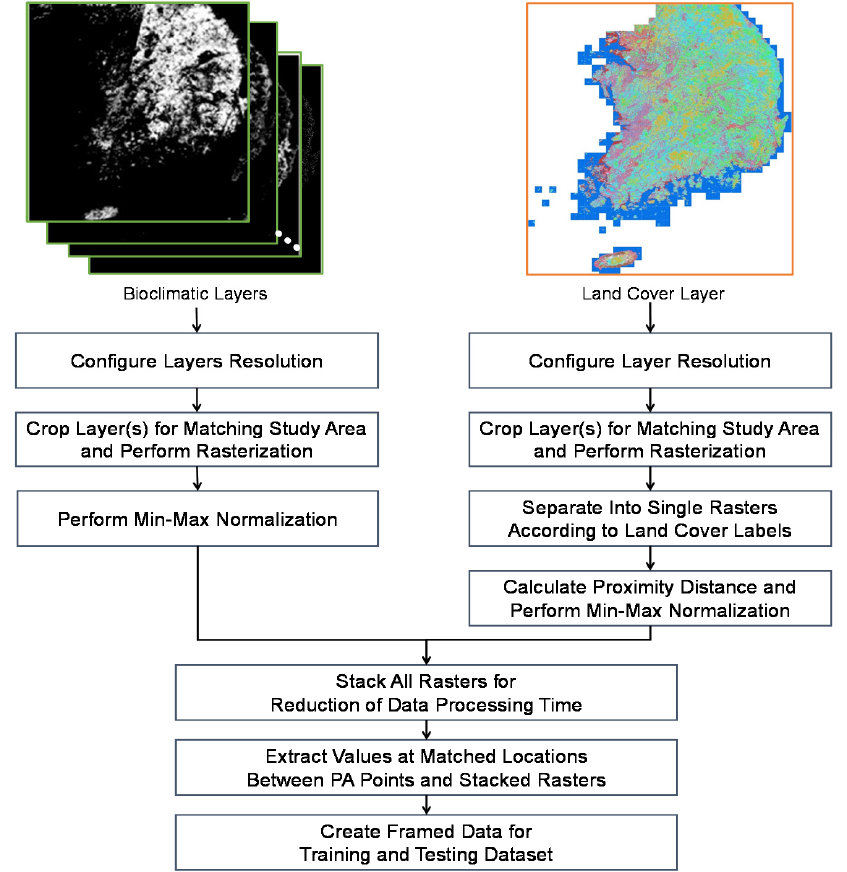
Figure 2. The overall preprocessing process for the present study.